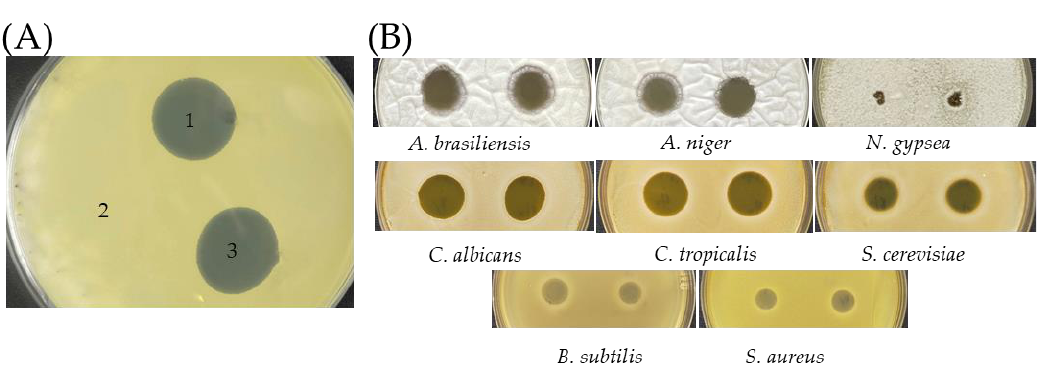
Figure 5. Antibiotic activities of SC263 membrane filtrate. ( A ) Different fractions of SC263 cultured broth were tested against C. albicans . 1: culture broth; 2: filtrate < 100 kDa; 3: compounds > 100 kDa (F100 Fraction). ( B ) Reconstituted lyophilized powder was tested for zone of inhibition in duplicate spots against different fungi and Gram-positive bacteria.